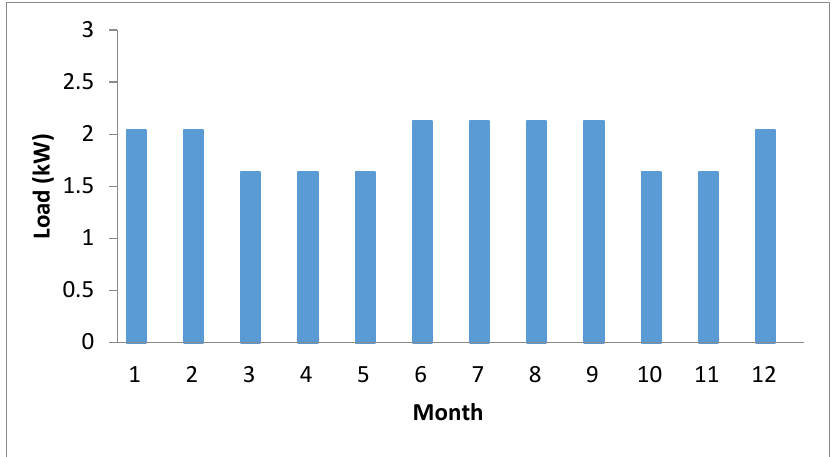
Figure 3. Monthly average electricity consumption.